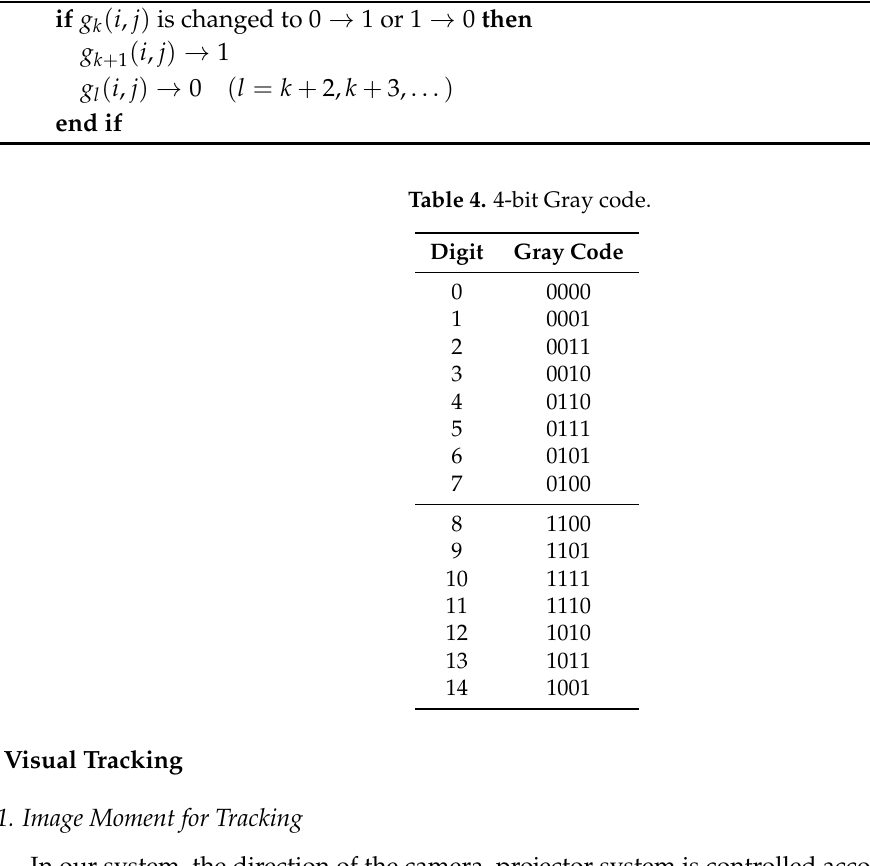
Algorithm 1: Correction of spatial code.